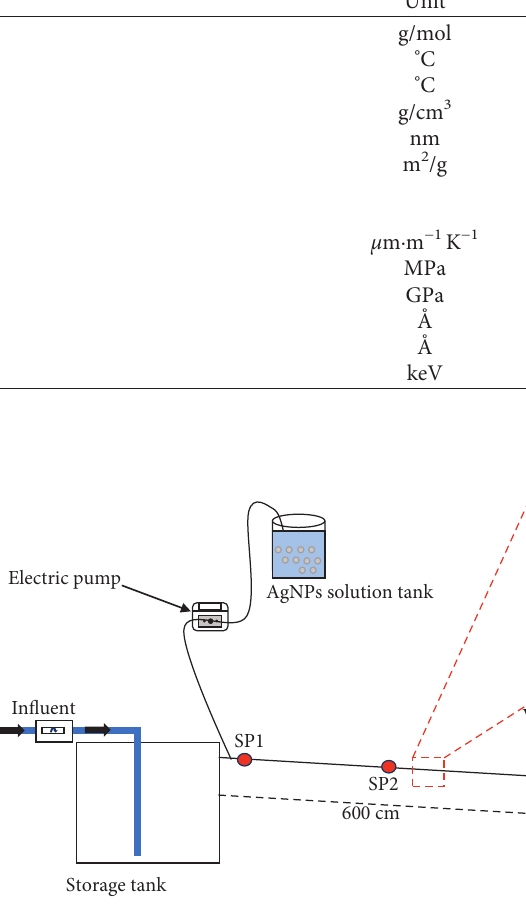
Figure 1: Schematic of the simulated river system.